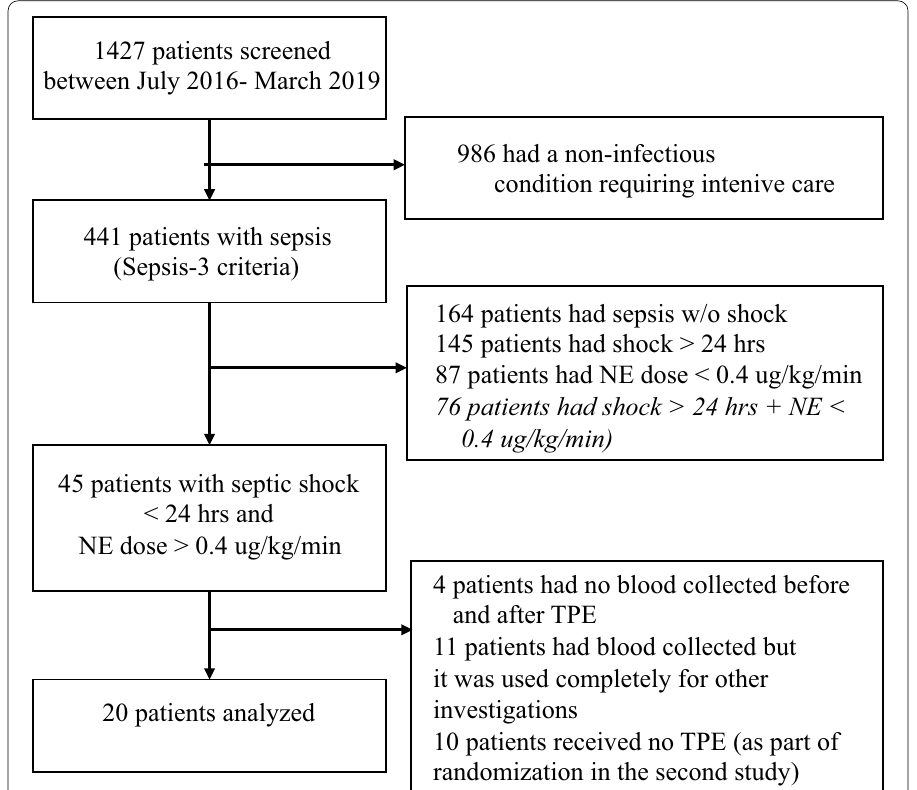
Fig. 1 Flowchart of study participants. NE means norepinephrine and TPE therapeutic plasma